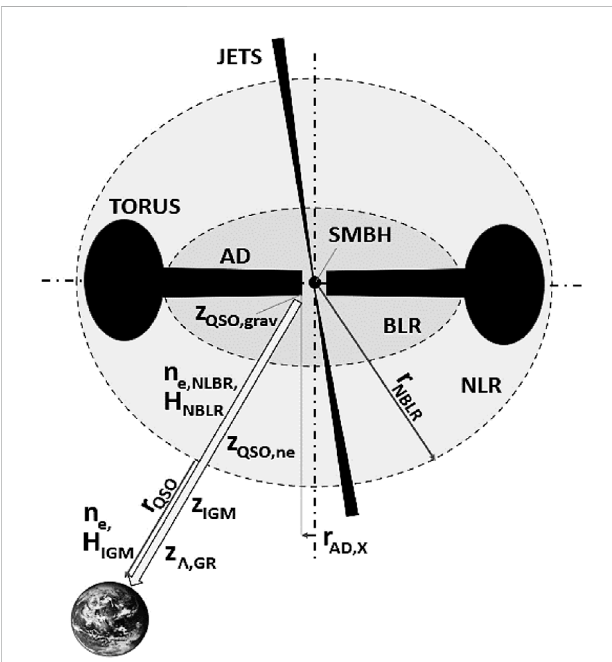
FIGURE 11 Schematization of the uni fi ed AGN model of a QSO from a terrestrial observer (not on scale) in the context of transit physics. The long solid arrow represents the photon path undergoing chain electron encounters in the broad and narrow line regions and in the IGM. The departure point is the most inner radius of the accretion disk from which X-ray photons